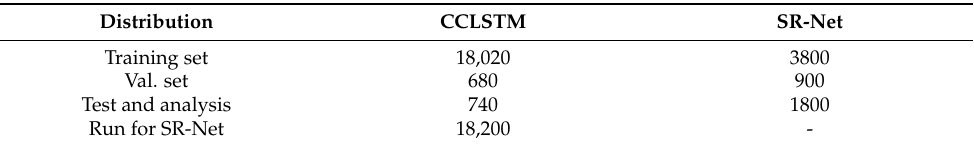
Table 1. Number of images of each model dataset. The datasets of SR-Net were selected from the results of the